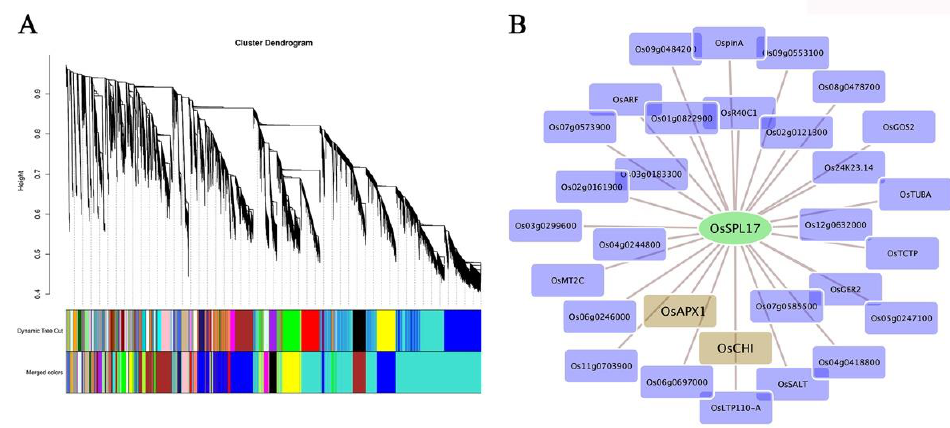
Figure 6. Weighted gene co-expression network in PA64S. ( A ) Hierarchical cluster tree. ( B ) Gene co-expression network of the darkturquoise module. Green indicates the core genes in the module. Brown color indicates the genes that interact with the core genes in our module of interest.